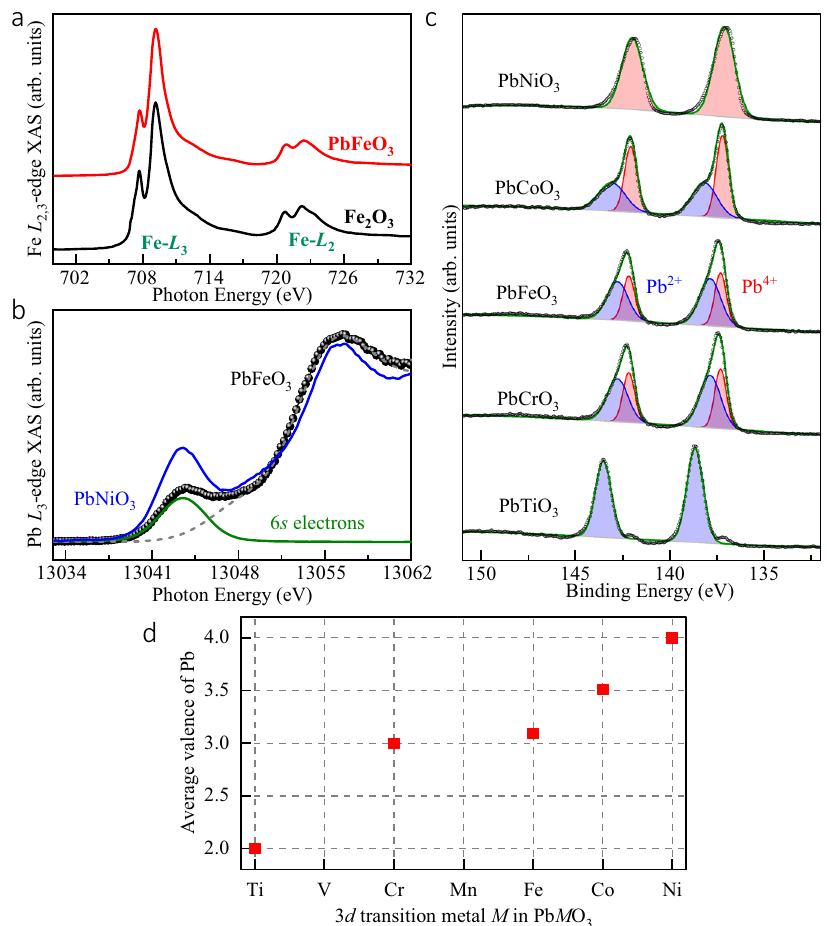
Fig. 2 Valence-state characterization by XAS and HAXPES spectra. a XAS of Fe L 2,3 -edge of PbFeO 3 , and reference Fe 2 O 3 ; b Pb L 3 -edge XANES of PbFeO 3 (black circles) and PbNiO 3 (blue curve) for comparison. The green curve in ( b ) shows the pre-edge peak 6 s state of PbFeO 3 after subtracting the background (dashed gray curve). c Pb-4 f HAXPES results for PbTiO 3 , PbCrO 3 , PbFeO 3 , PbCoO 3 , and PbNiO 3 at RT. Predominant of Pb 4 + and Pb 2 + are evident in the spectrum for PbFeO 3 . d Average Pb valence state calculated from area ratios of Pb 2 + and Pb 4 + components. PbTiO 3 , PbCrO 3 , and PbNiO 3 are standard for Pb 2 + , Pb 3 + (Pb 2 + 0.5 Pb 4 + 0.5 ), and Pb 4 + ,